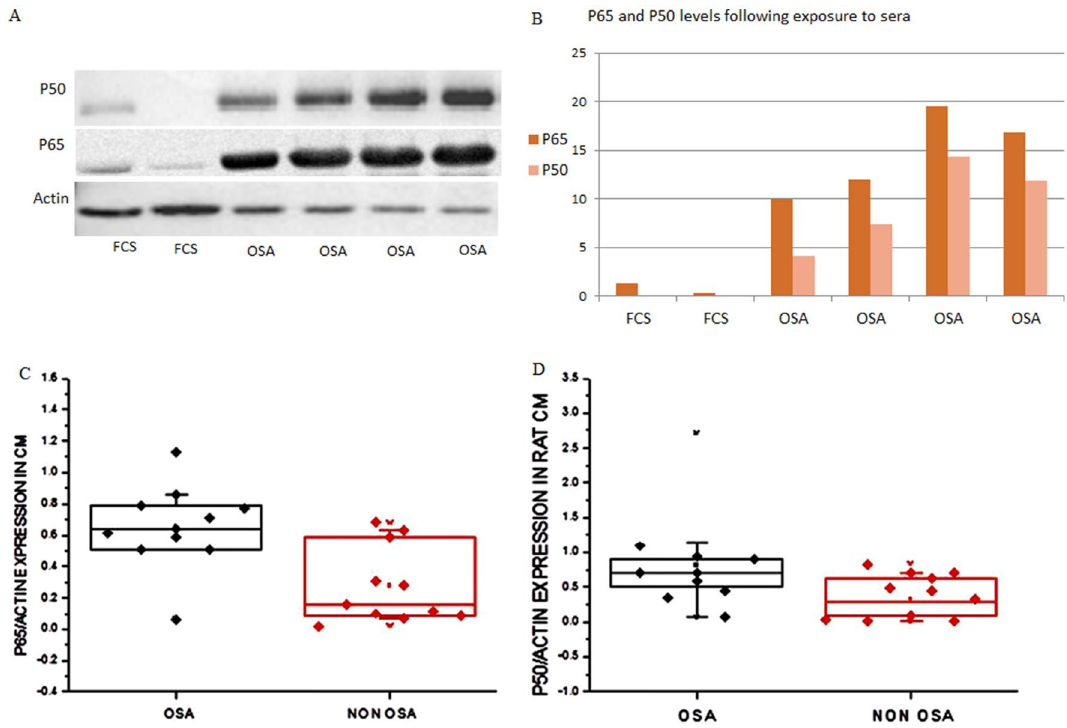
Figure 1. ( A ) Western blot of NFκB sub-units P65 and P50 in whole cell lysates prepared from neonatal rat CM following 2 h exposure to OSA sera or FCS. ( B ) Densitometry of the western blot shown in ( A ). Bands were normalized to their respective actin bands. CM were incubated with 5% OSA or FCS in M-119 medium. Statistical distribution of ( C ) P65 and ( D ) P50 expression levels in whole cell lysates prepared from neonatal rat CM exposed to OSA (black) or non-OSA (red) sera. Horizontal lines represent median values; the upper and lower box limits indicate the 25th percentile and 75th percentile; whiskers represent the 10th and 90th